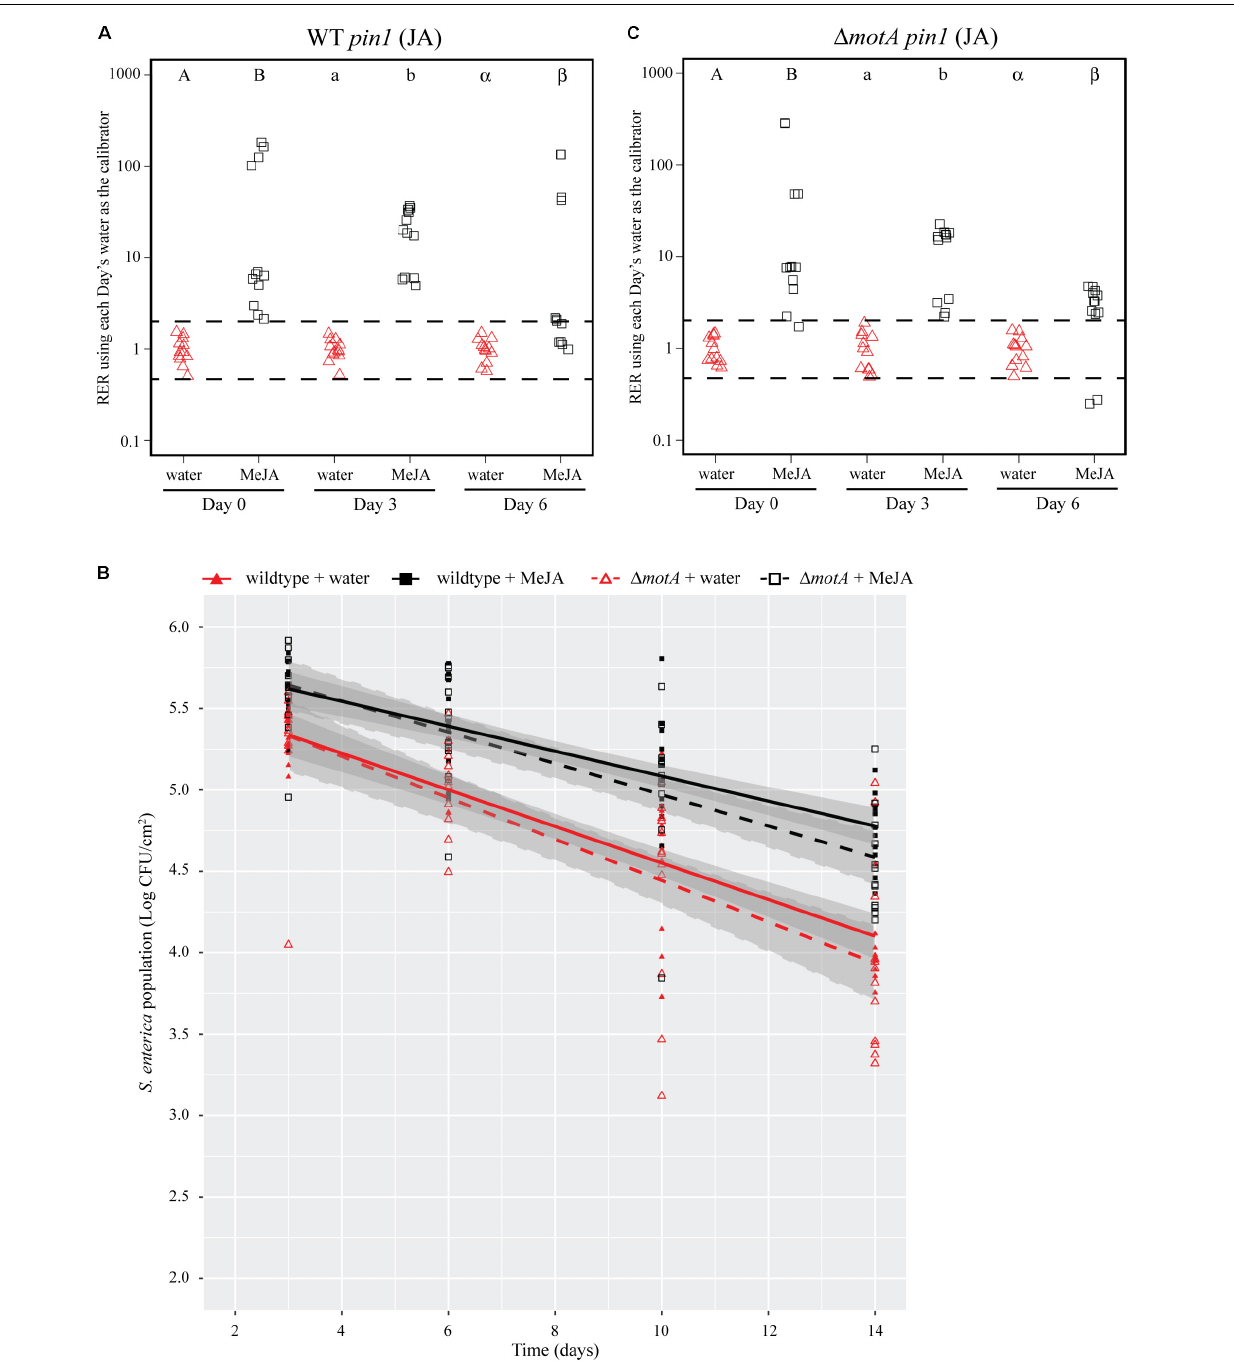
Frontiers in Microbiology |